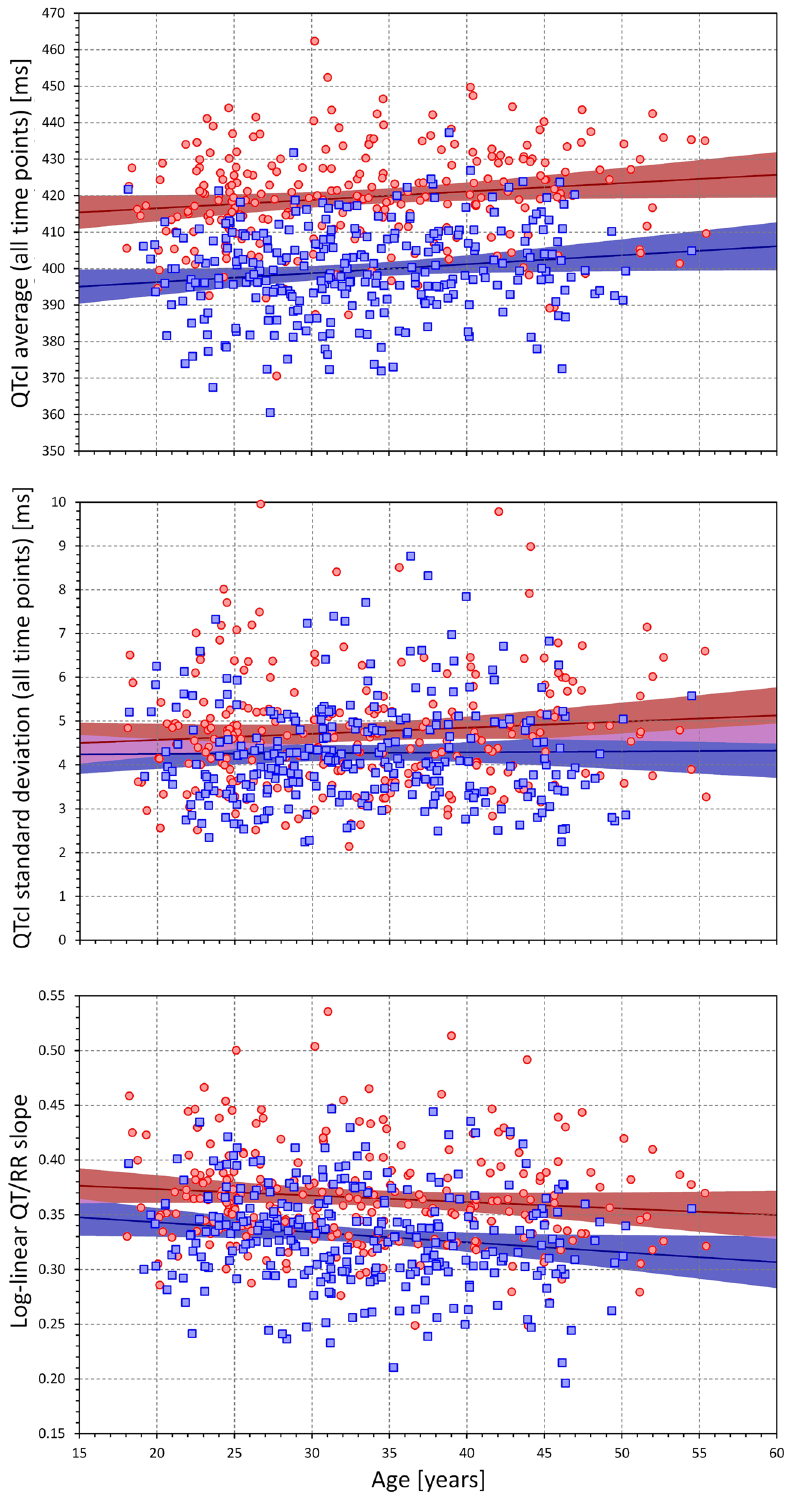
Figure 3. Scatter diagrams between age and mean QTcI values of all ECG measurements in all study time- points (top panel), standard deviation of QTcI values of all ECG measurements in all study time-points (middle panel), and subject-specific log-linear QT/RR slope (bottom panel). In each panel, the red circles and blue squares correspond to female and male subjects, respectively. The solid red and solid blue lines show the linear regressions between the age and the measured QT characteristics in females and males, respectively. The red shaded and blue shaded areas are the 95% confidence intervals of the regression lines; the violet areas are the overlaps between the confidence intervals of the sex-specific regressions. ms